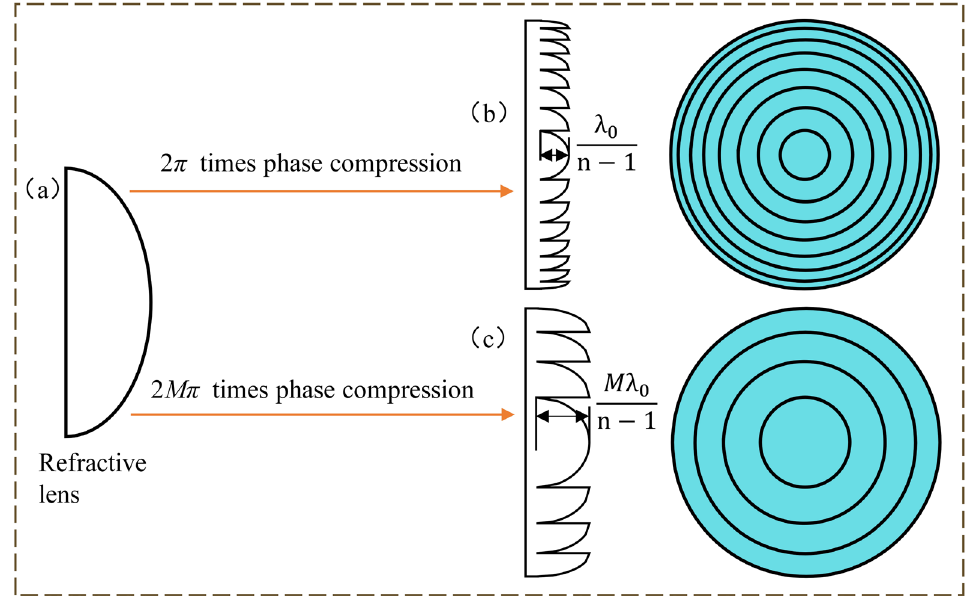
Figure 2. ( a ) Ideal refractive lens; ( b ) Schematic diagram of DOE; ( c ) Schematic diagram of HDOE.